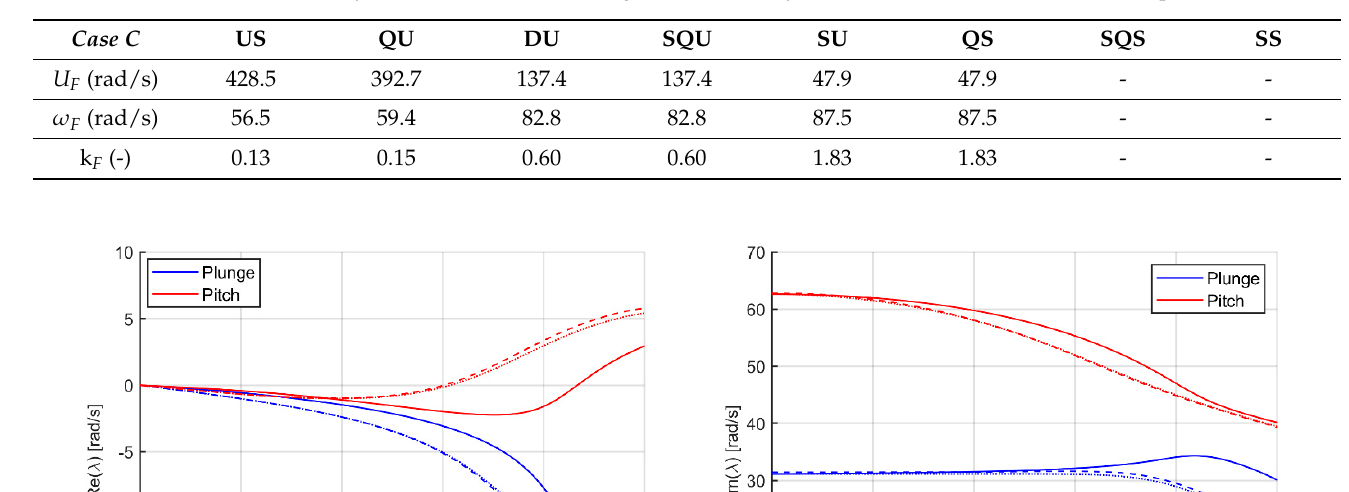
Table 7. Flutter analysis results for Case C using different aerodynamic models; elastic axis at control point.